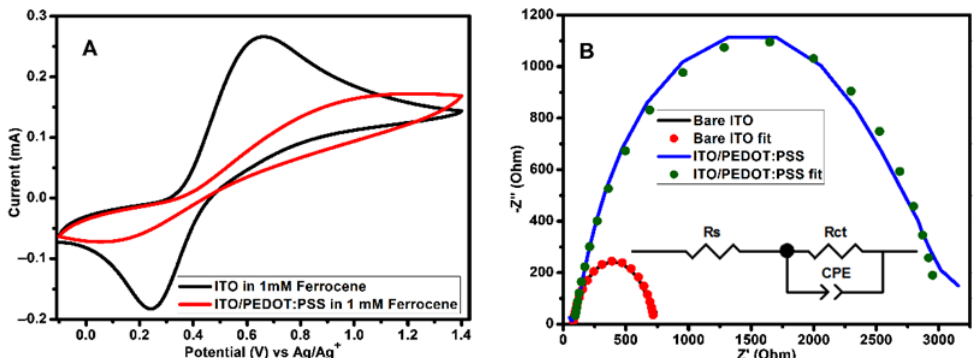
Figure 6. ( A ) CV (measured at 100 mVs − 1 scan rate) and ( B ) Nyquist plots of 1 mM ferrocene obtained using bare ITO and ITO/(PEDOT:PSS as working electrodes in 0.1 M TBAPF 6 /acetonitrile solution. The Nyquist plots were attained at bias potential of 0.45 V vs Ag/Ag + . The equivalent circuit used for impedance data fitting is shown as an inset on ( B ). ITO—indium tin oxide; PEDOT:PSS—poly(3,4-ethylenedioxythiophene) polystyrene Table 4. Results obtained from fitting electrochemical impedance data of bare ITO and ITO/PEDOT:PSS.